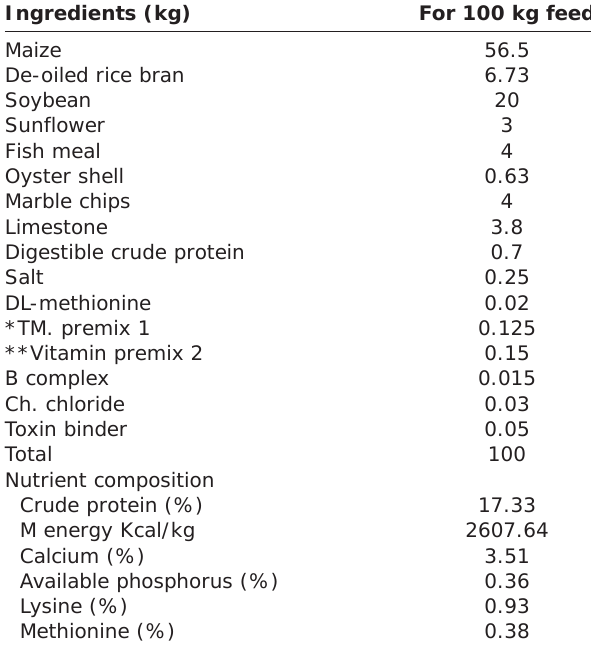
Table-1: Formula and chemical composition of broiler breeder ration. Ingredients